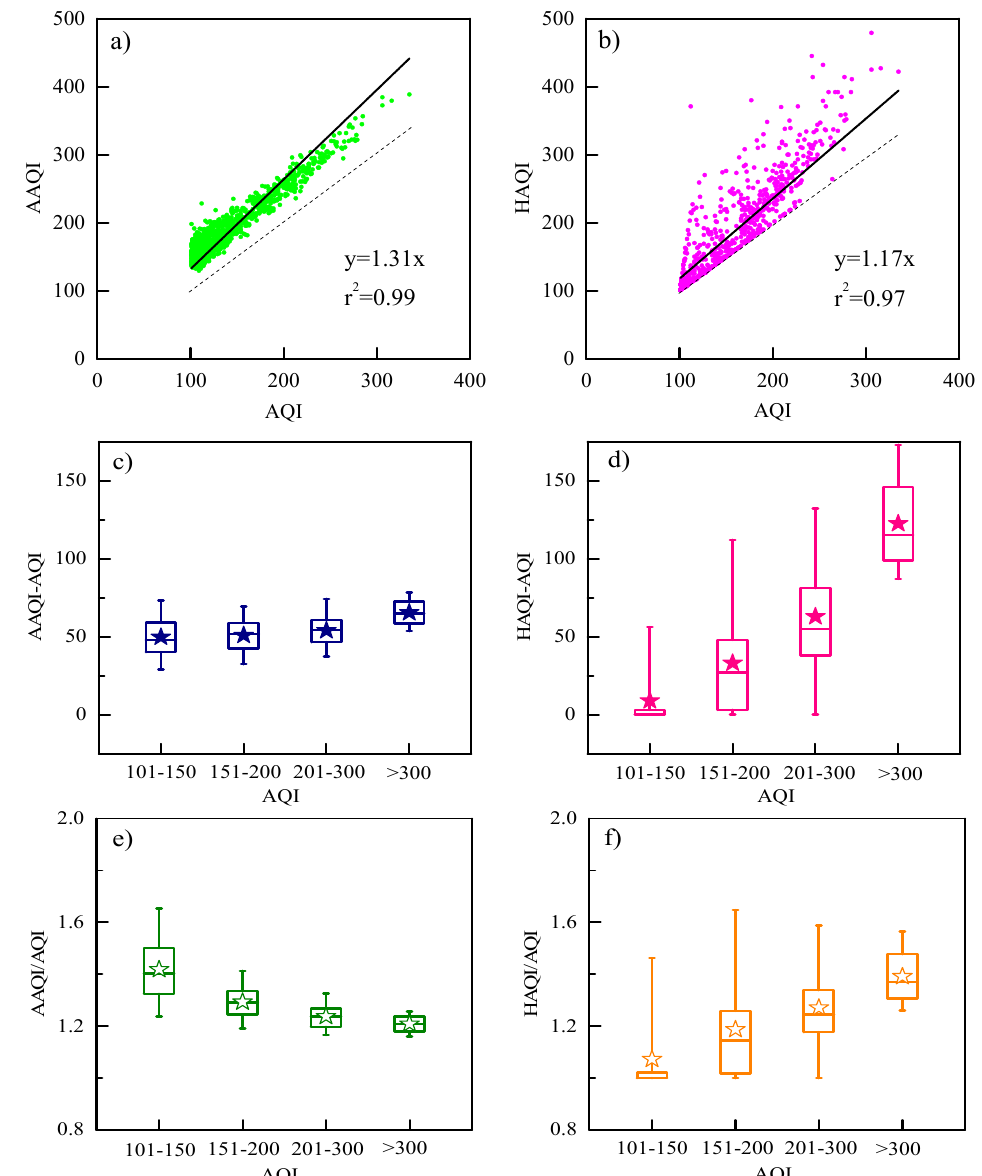
Figure 7. Scatter plots between the air quality index (AQI) and ( a ) aggregate AQI (AAQI) and ( b ) health risk-based AQI (HAQI). Whiskers box plots between the AQI and ( c ) AAQI–AQI, ( d ) HAQI–AQI, ( e ) AAQI/AQI, and ( f ) HAQI/AQI. The top and bottom whiskers show the 95th and 5th percentiles, the upper and lower boundaries of the central box indicate the 75th and 25th percentiles, the middle line of the box indicates the median, and the pentacle indicates the arithmetic average.